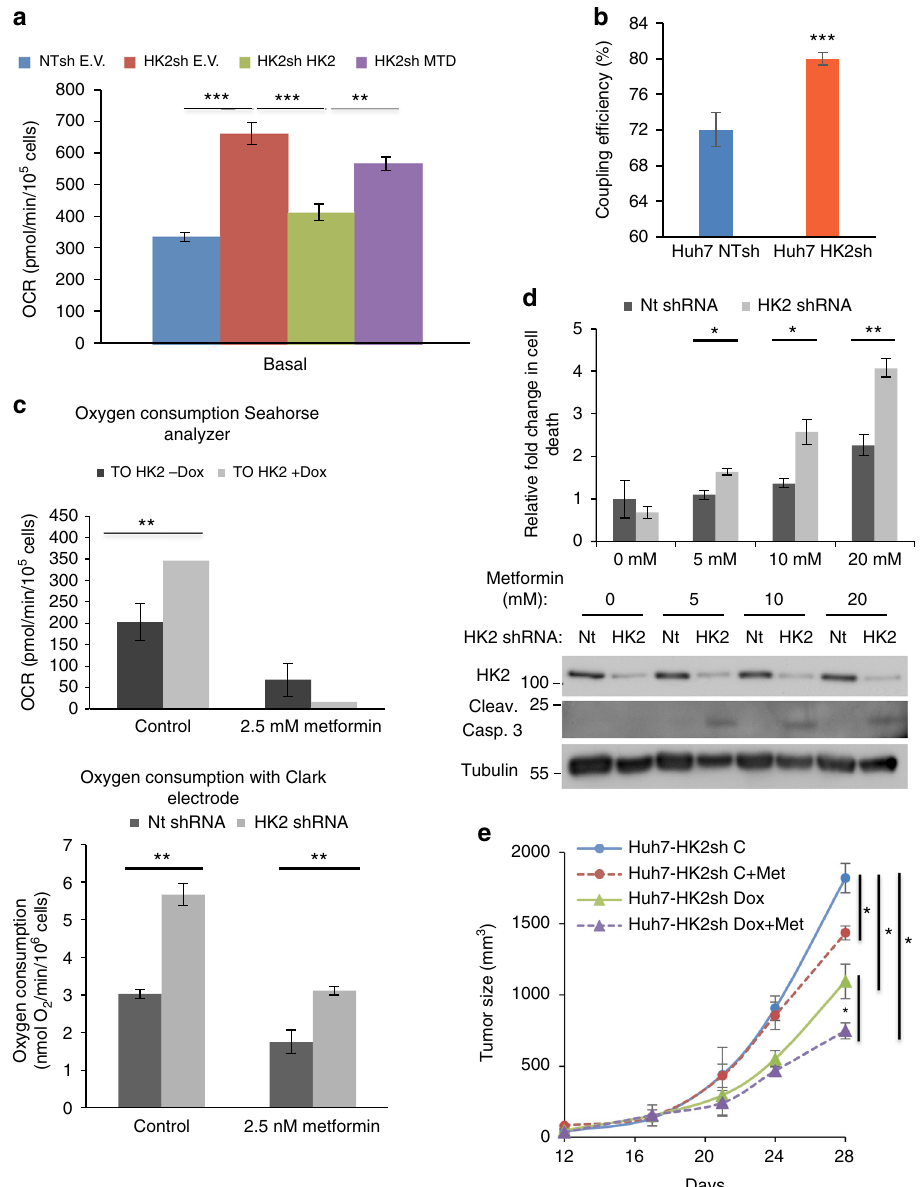
Fig. 6 Effect of HK2 KD and metformin on Huh7 HCC cells. a Seahorse metabolic analysis of oxygen consumption rates (OCR). b Coupling ef fi ciency as calculated from OCR data generated with Seahorse analyzer, as the ratio between ATP-linked respiration and basal respiration rate. Data are the average of two experiments done in quadruplet. c The effect of metformin on oxygen consumption as measured by the Seahorse analyzer (upper panel) and by the Clark electrode (lower panel). Cells were treated with the indicated concentrations of metformin for 24 h. d Cell death after HK2 KD in combination with metformin, upper panel — quanti fi cation of PI staining, lower panel — caspase 3 cleavage. e Huh7 cells with Dox-inducible HK2 shRNA were subjected to subcutaneous tumor growth. After tumor appearance, mice were exposed to either a Dox-infused diet alone, metformin alone or both. Tumor size was measured every 4 days, and tumor growth was plotted ( n = 4 per each treatment). The results represent mean ± SEM, * p < 0.05, ** p < 0.01 *** p < 0.005 by Student ’ s t